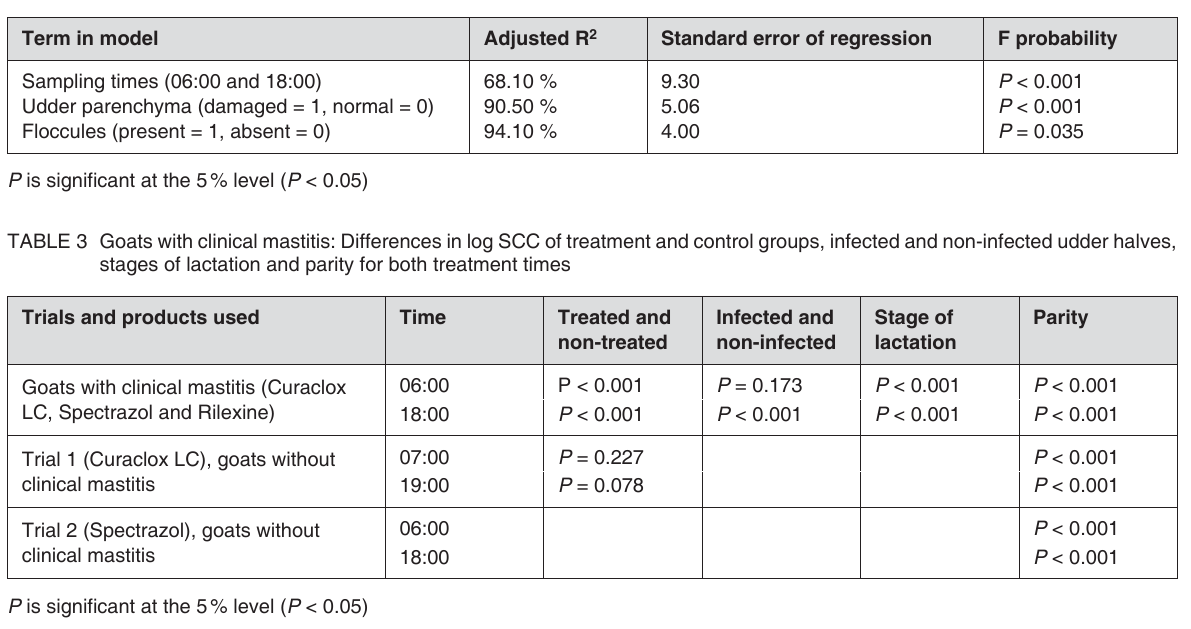
TABLE 4 Goats with clinical mastitis: Correlation matrix (Curaclox LC, Spectrazol and Rilexine) excluding withdrawal period as measured by TRIS (degrees of freedom = 332) Log SCC 1 1 Milk yield 2 R 2 = –0.283 CMCT